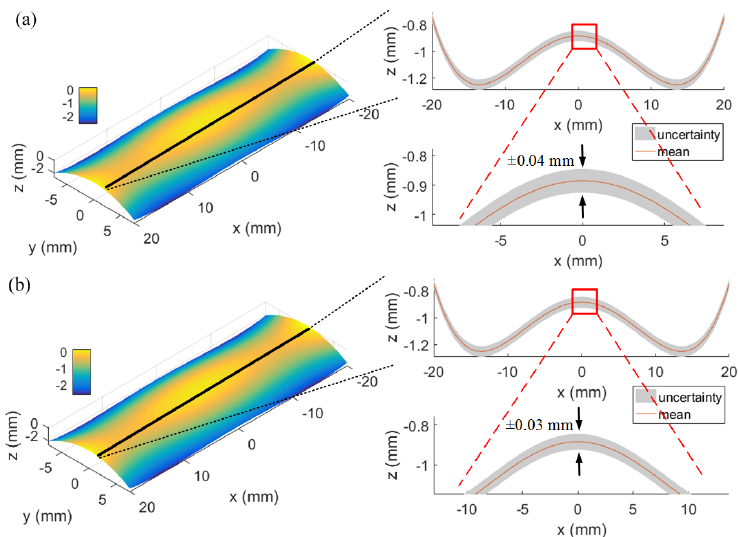
Figure 11. Gaussian process modelling results of the two simulated measured datasets: ( a ) with 40 μ m measurement noise; and ( b ) with 30 μ m measurement noise.